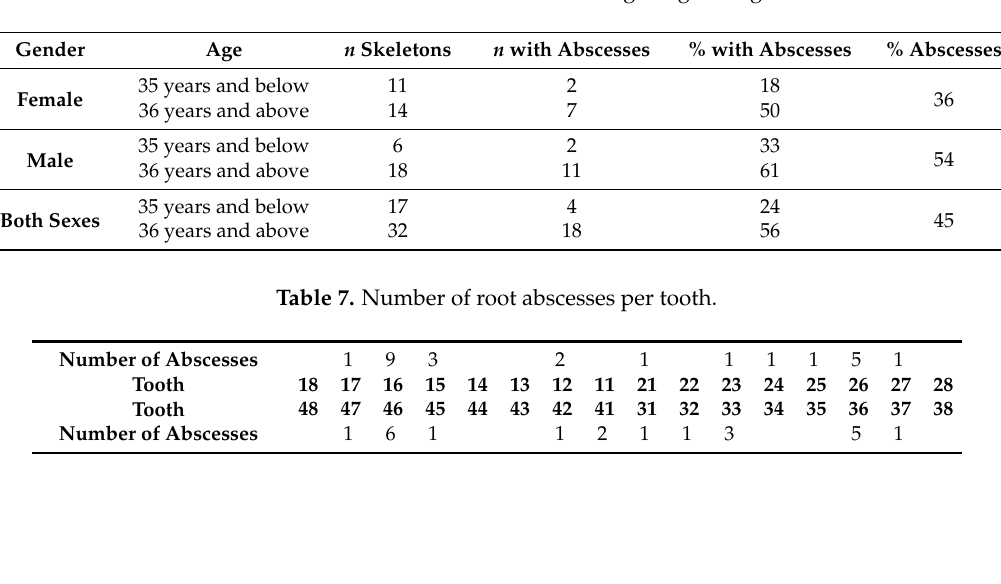
Table 6. Prevalence of root abscesses according to age and gender.